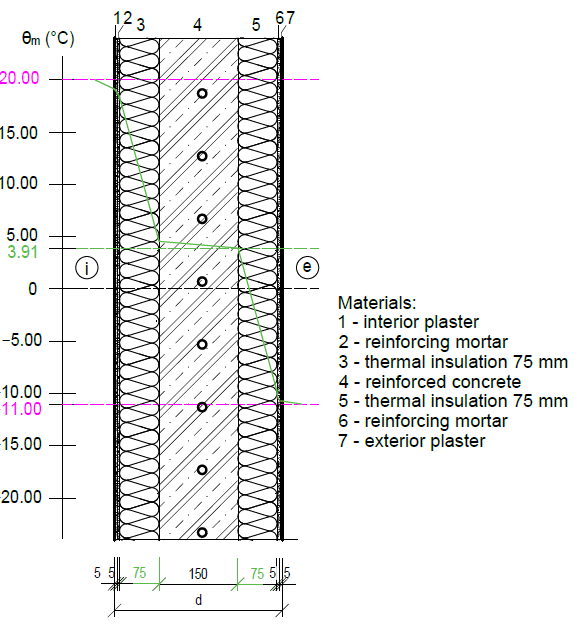
to 200 mm, Figure 12.